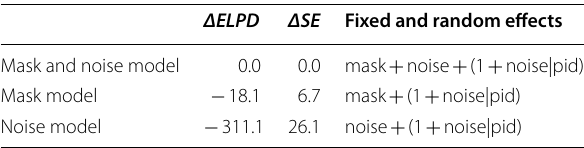
Table 4 Change in LOO information criterion relative to the best fitting model without an interaction term for the subjective listening effort analysis in young adults